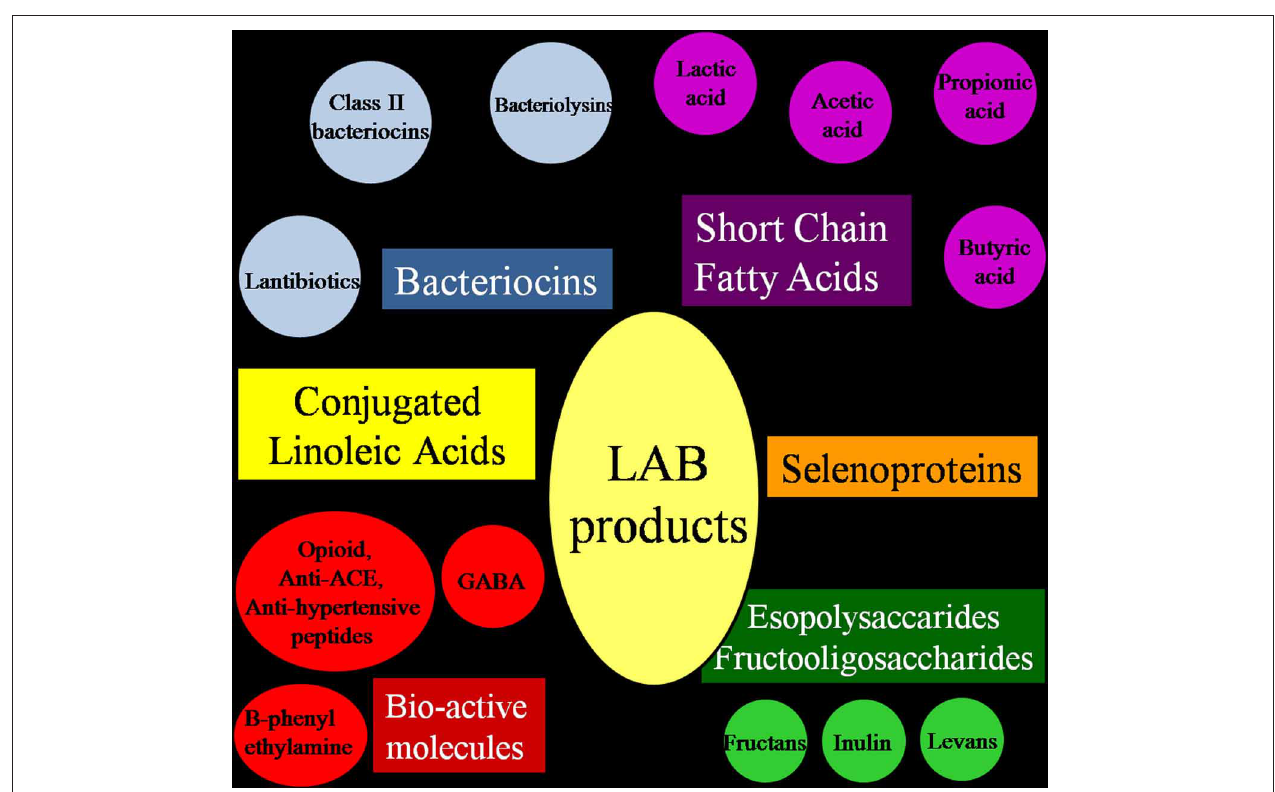
FIGURE 3 | Molecules contributing to the nutraceutical and probiotic potential of Lactic Acid Bacteria.